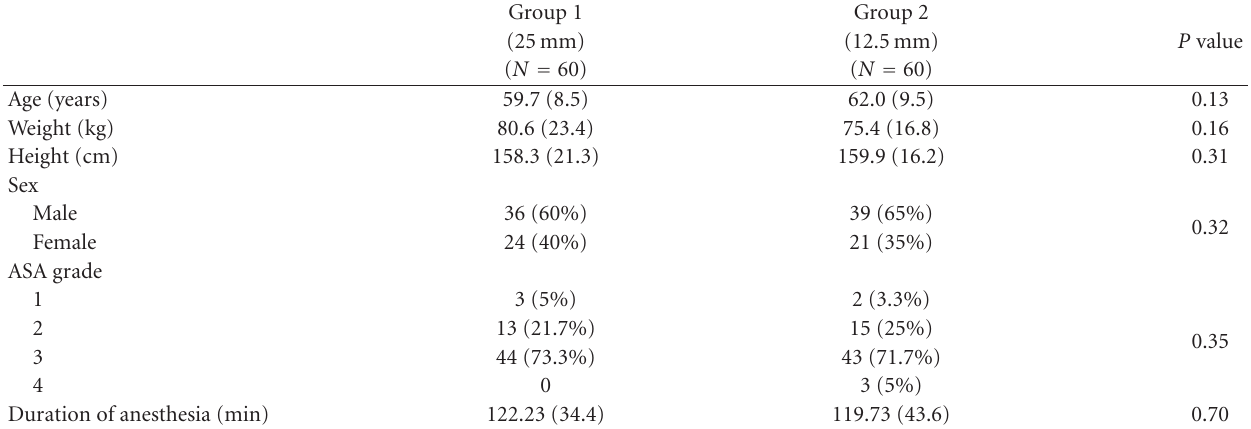
Table 1: Demographic and descriptive data.